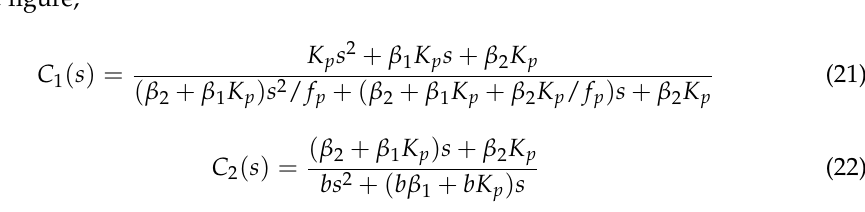
Table 1. Parameters and performance of designed controllers.